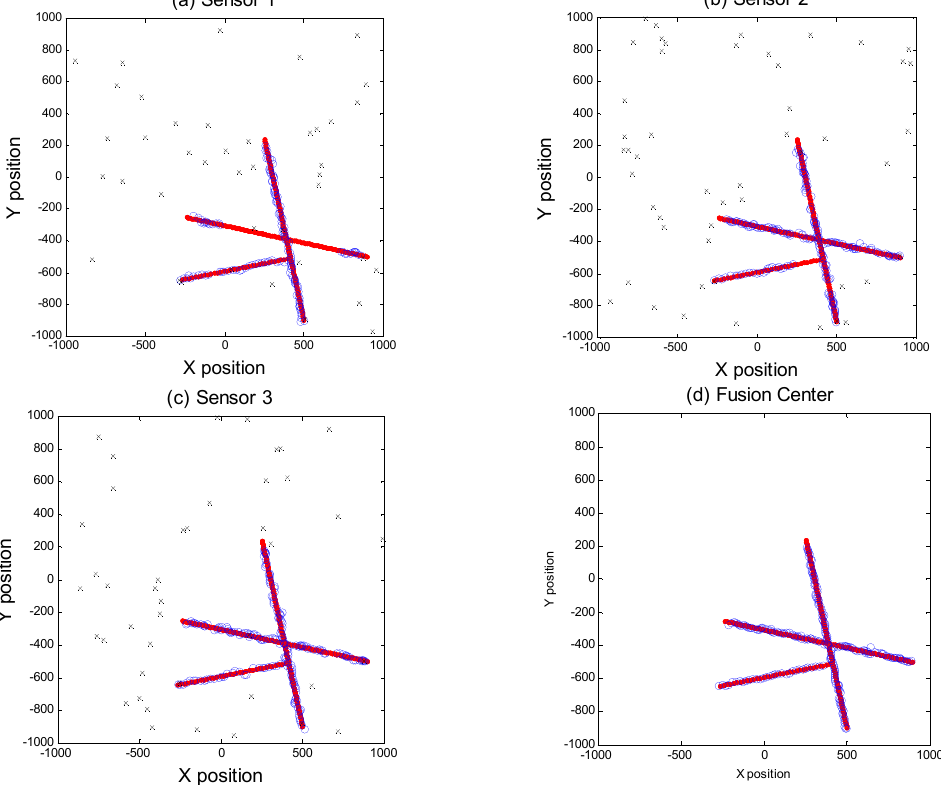
Figure 12. Tracking simulation of the target in acoustic shadow zone.